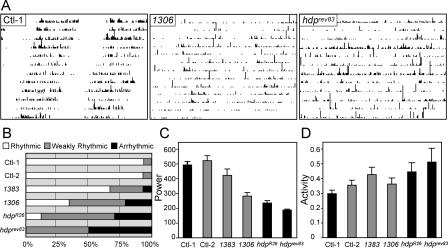
Wild-Type Lmo Is Required for Robust Circadian Rhythms of Locomotor ActivityLocomotor activity of control (Ctl-1 and Ctl-2) and Lmo mutant (EP1383, EP1306, hdpR26, and hdprev83) flies was recorded in constant darkness as previously described (Nitabach et al. 2002).(A) Representative actograms of control and Lmo mutants. Control flies show robust circadian rhythms with clear distinctions between activity during the subjective day and inactivity during the subjective night. The pattern of the EP1306 and hdprev83 mutants was more stochastic.(B) Graph showing the proportion of strongly rhythmic (white), weakly rhythmic (gray), and arrhythmic (black) flies for each genotype. Most control flies had strong rhythms (28/30 for Ctl-1 and 27/29 for Ctl-2) while Lmo mutants formed a series with an increasing fraction of the flies arrhythmic. For example, 13/26 hdprev83 flies were arrhythmic, with the other 13 all having weak rhythms. The power of the rhythm was used to estimate the strength of the activity rhythm, with a power of 300 or more classed as a strong rhythm and a power between 300 and 170 classed as a weak rhythm; arrhythmics were given a power of 170 (for analysis below). Between 24 and 30 flies were assayed for each genotype. There were no major differences in the period length of the rhythmic flies in each genotype (Ctl-1, 23.6 ± 0.3; Ctl-2, 23.5 ± 0.5; EP1383, 23.2 ± 0.4; EP1306, 23.4 ± 0.3; hdpR26, 24.2 ± 0.5; and hdprev83, 23.4 ± 0.3).(C) Quantitation of the average power of the rhythm with error bars showing standard error of the mean. One-way ANOVA revealed significant differences between genotypes (p < 0.0001). Post-hoc t-tests using a Bonferroni correction revealed that the power of the rhythm was significantly different between control flies and the Lmo mutants hdpR26, hdprev83, and EP1306 (p < 0.01). EP1383 flies had a significantly weaker rhythm than Ctl-2 flies (p < 0.05). Ctl-1, w1118, is the appropriate genetic control for the hdp alleles (black columns); Ctl-2, EP1631, is the appropriate control for EP1306 and EP1383 (gray columns). All flies tested are in the same genetic background, that of the w1118 flies.(D) Quantitation of average activity (beam crossings per minute) with error bars showing standard error of the mean. ANOVA did not reveal significant differences between genotypes at the 0.01 level. Ctl-1, w1118, is the appropriate genetic control for the hdp alleles (black columns); Ctl-2, EP1631, is the appropriate control for EP1306 and EP1383 (gray columns). All flies tested are in the same genetic background, that of the w1118 flies.